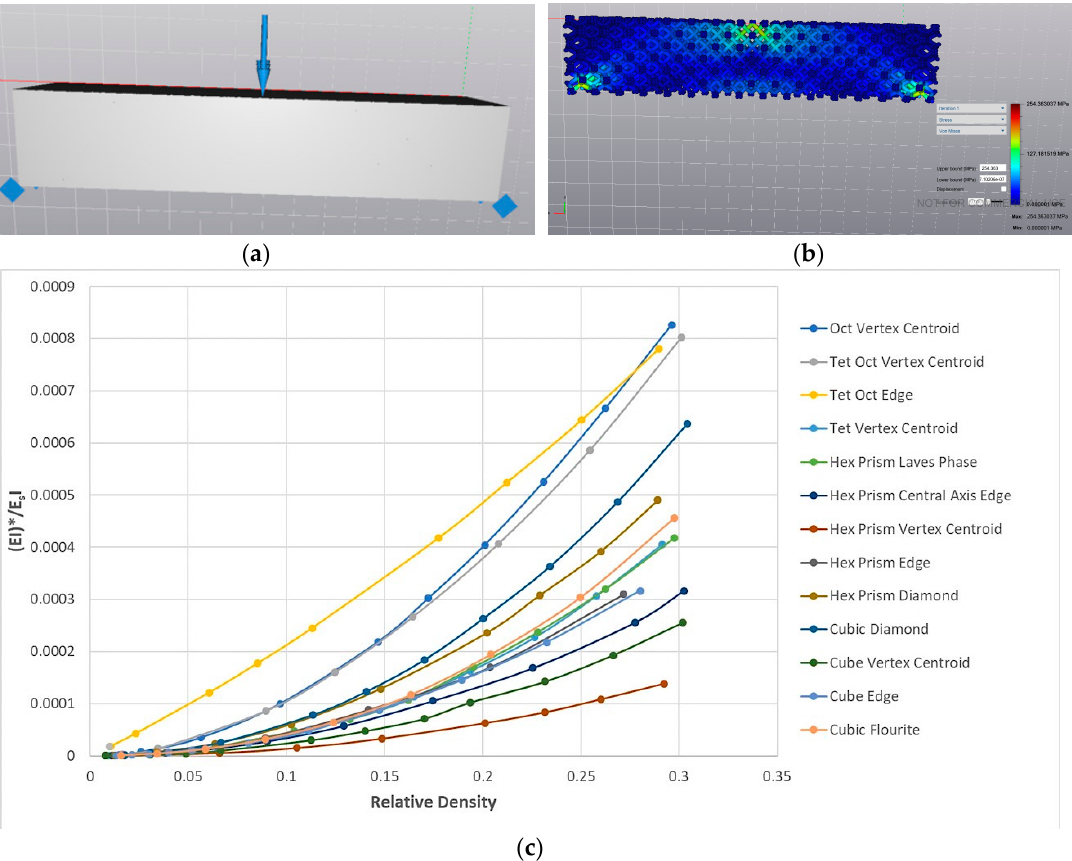
Figure 6. Empirical study conducted with nTopology’s Element software [21] to identify cellular material with the highest geometric efficiency for bending stiffness: ( a ) model setup; ( b ) typical stress contours and ( c ) graph comparing different cell shapes across a range of relative densities.